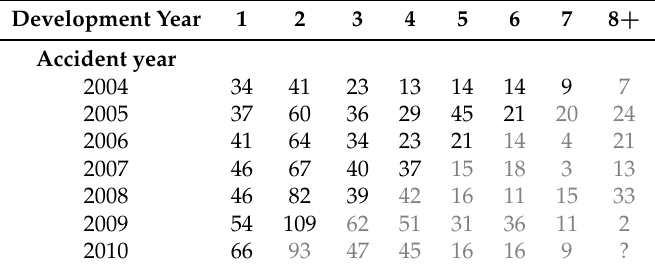
Table 3. Validation incremental run-off triangle (in